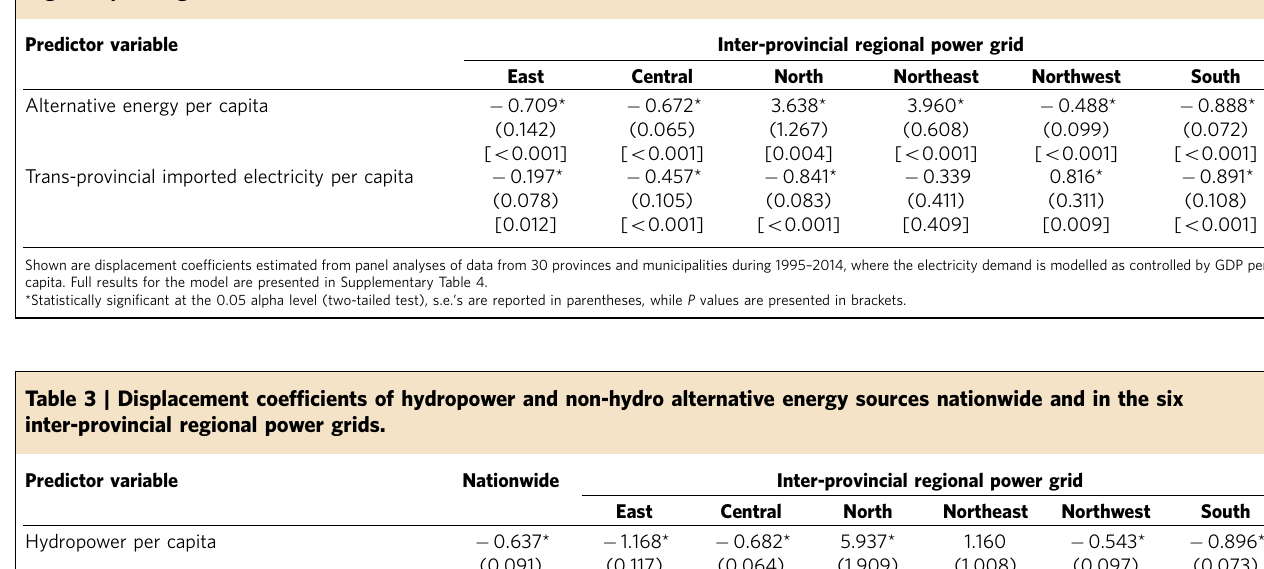
Table 2 | Displacement coefficients of alternative energy and trans-provincial imported electricity in China’s six inter-provincial regional power grids.